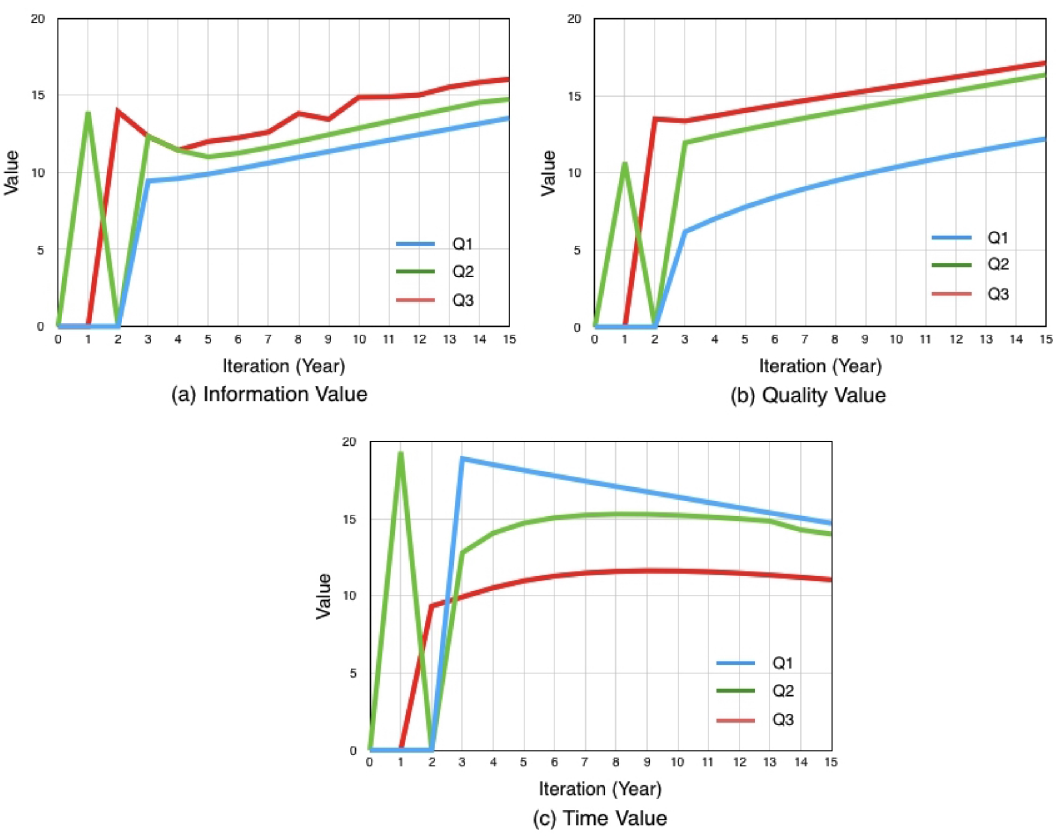
Figure 6. Value Generated in Planning Stage: (a) Information Value, (b) Quality Value, and (c) Time